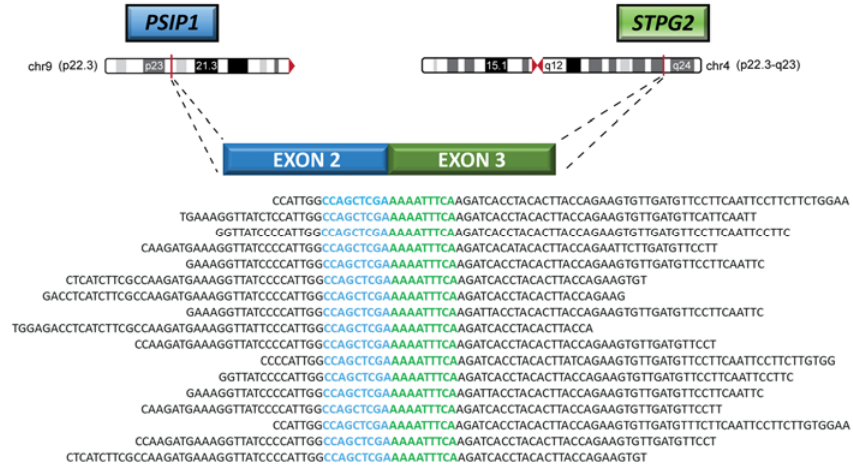
Figure 7. Representation of the PSIP1 ‐ STPG2 fusion transcript supported by reads mapped on the